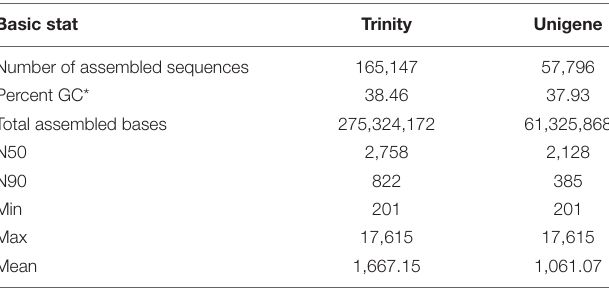
TABLE 1 | Summary statistics of the assembled transcriptome of S. argel plants and distribution of the generated sequence